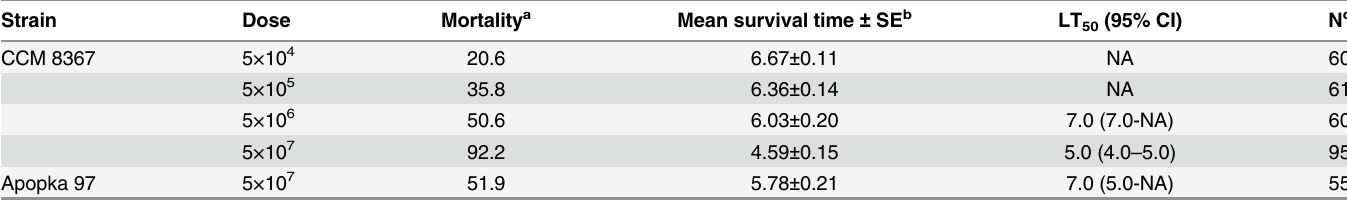
Table 2. Corrected mortality (%), mean survival time and LT 50 (days) of L . decemlineata last-instar larvae treated by CCM 8367 and Apopka 97 strains of I . fumosorosea .